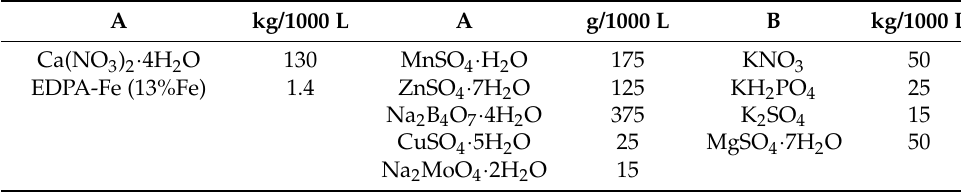
Table 3. Element components in the mother NS in different tanks (A,